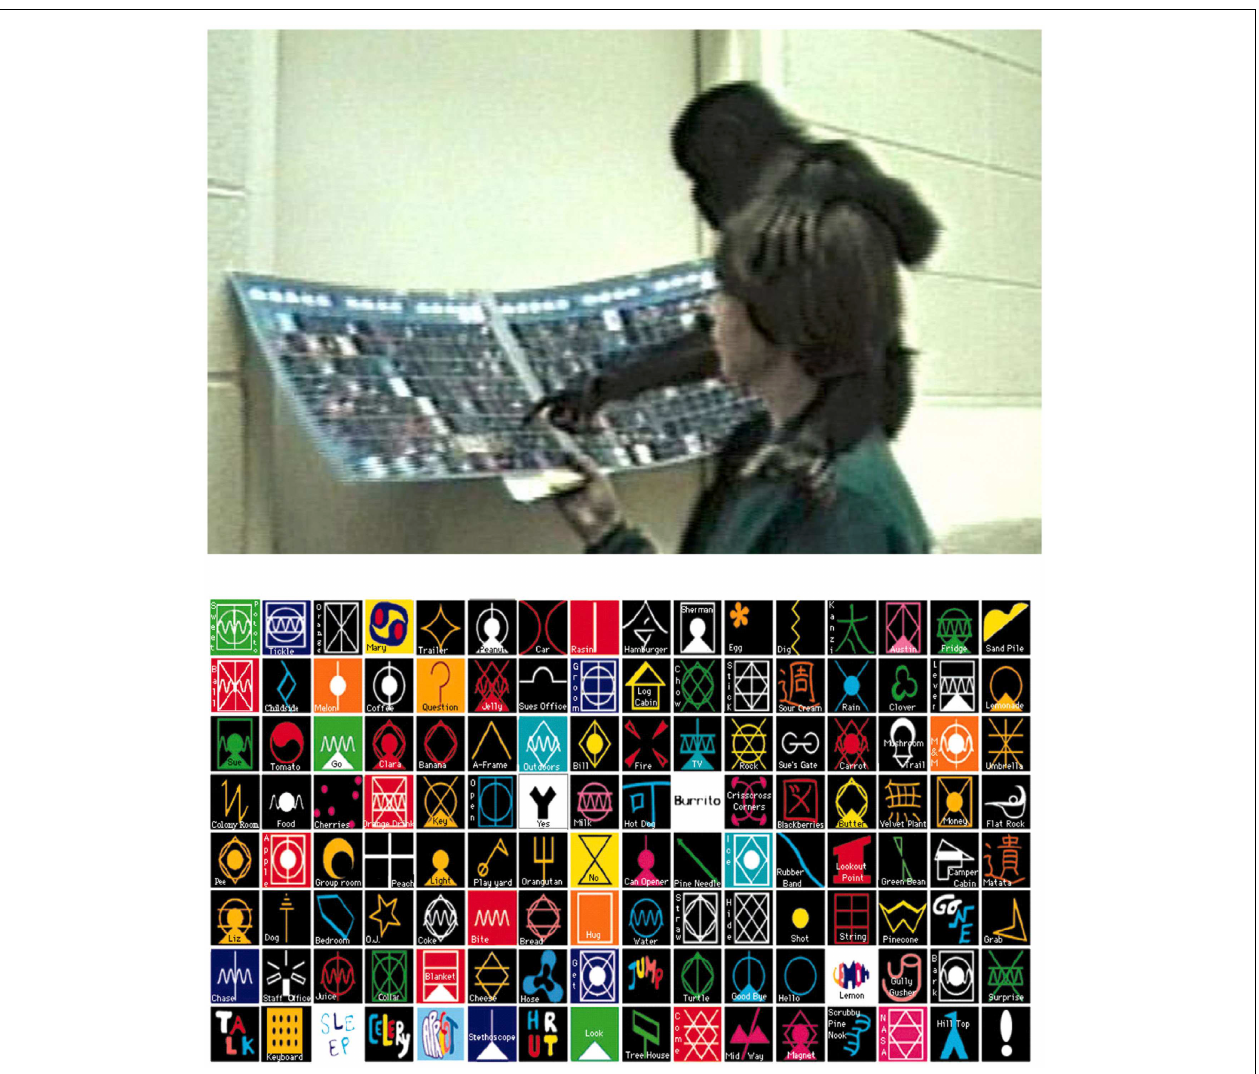
FIGURE 1 |An example of a lexigram use (top) and an image of lexigram board (bottom). Lexigram use was defined as touching a lexigram while the referent was glossed by caregiver or electronic voice on lexigram